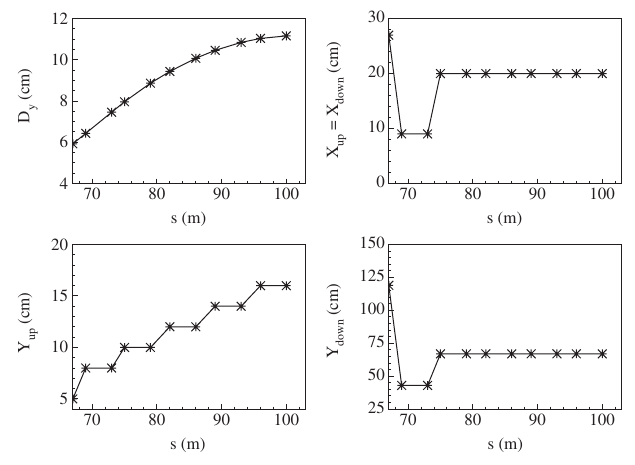
FIG. 17. Variations of the dimensions of the vacuum pipe for the disrupted beam and the beamstrahlung photons, from the separation region to the fourth C-type magnet exit.